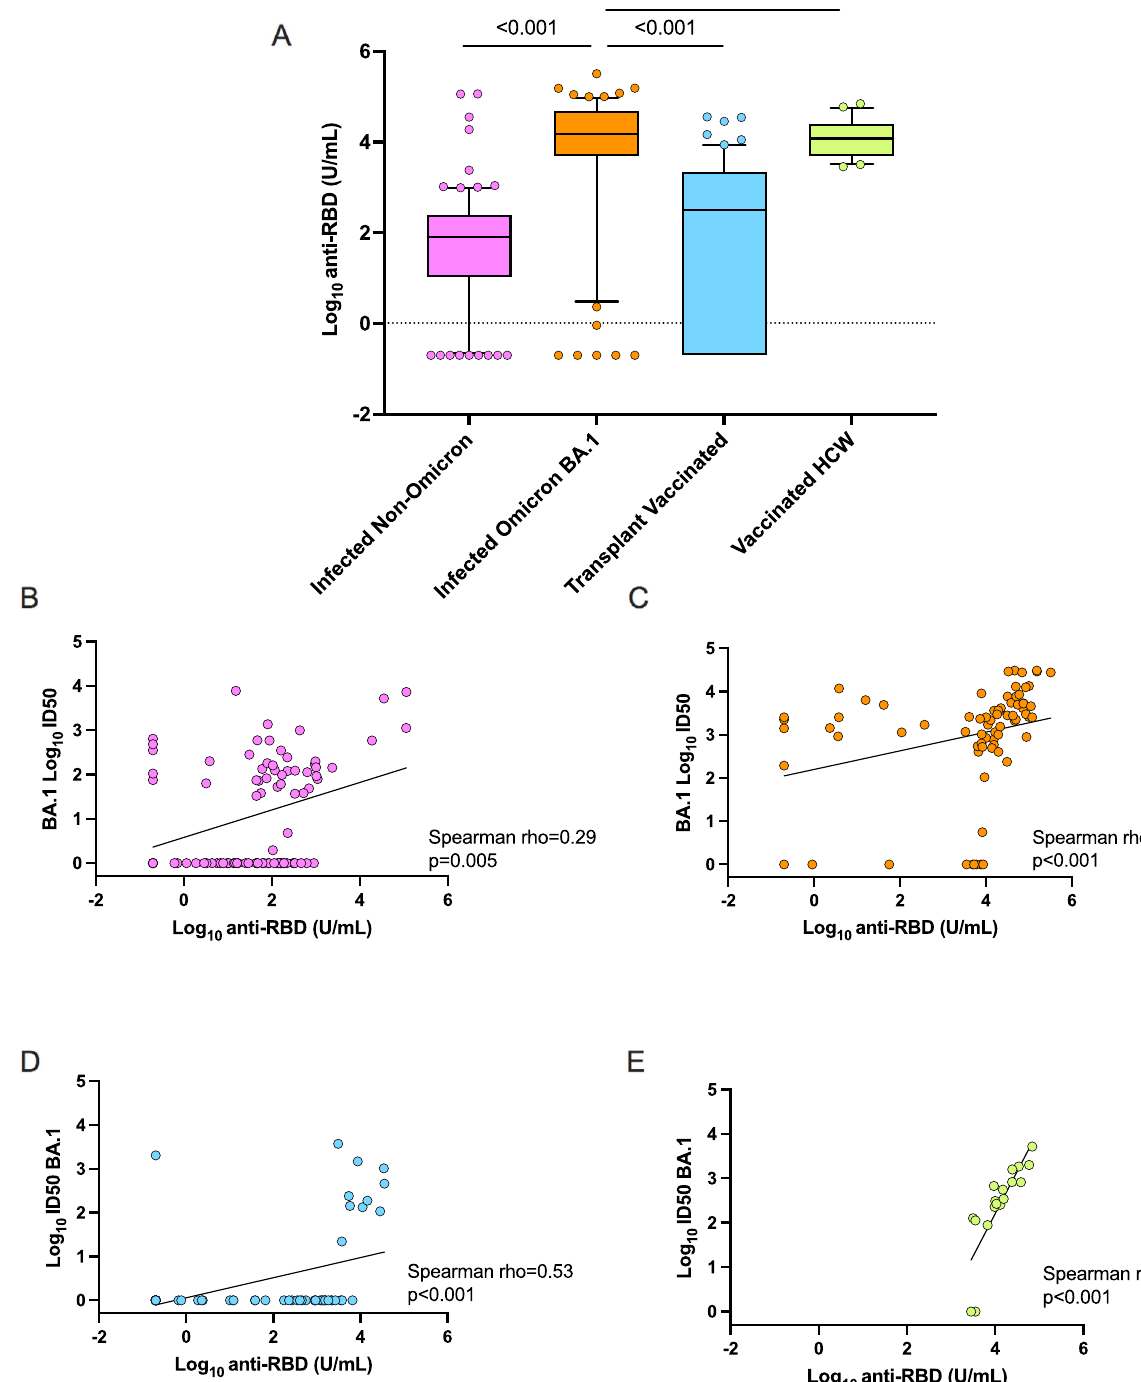
Fig.6|Anti-receptorbindingdomain(RBD)bindingantibodylevelresponseby cohort.A Box and whisker plots ofthe log 10 RBD binding antibody titer by cohort. In each box, the horizontal line represents the median value, with the bottom and the top of the box indicating the 25 and 75th percentile, respectively. Cohort 1: n =90,Cohort2: n =75,Cohort3: n =60,Cohort4: n =20.Circlesrepresentoutside values (individual patients with antibody titers far from the rest). A two-sided Kruskal – WallistestandposthocDunn ’ spairwisetestwasusedtocomparetheBA.1 infected cohort with the other cohorts. P values are shown above each respective